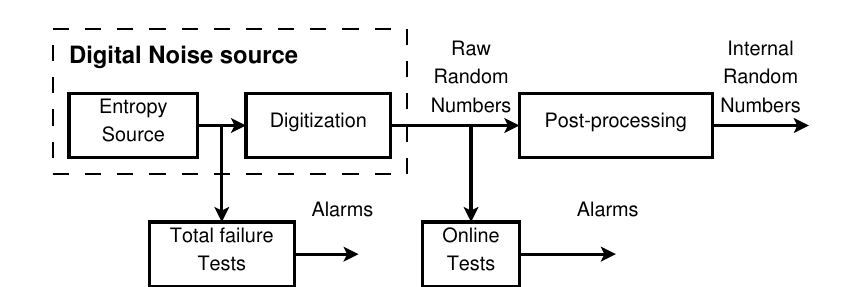
Figure 2: The generic architecture of a